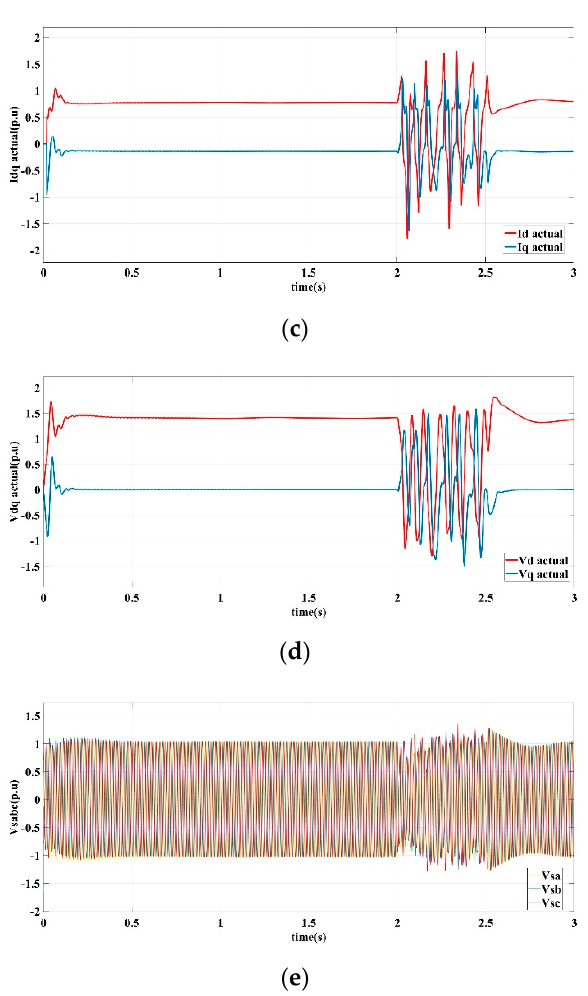
Figure 9. Fault ‐ tolerant control response curves in scenario III. ( a ) Current error estimation of d ‐ axis and q ‐ axis, ( b ) Voltage error estimation of d ‐ axis and q ‐ axis, ( c ) d ‐ axis and q ‐ axis current output, ( d ) d ‐ axis and q ‐ axis voltage output, ( e ) Three ‐ phase voltage output.